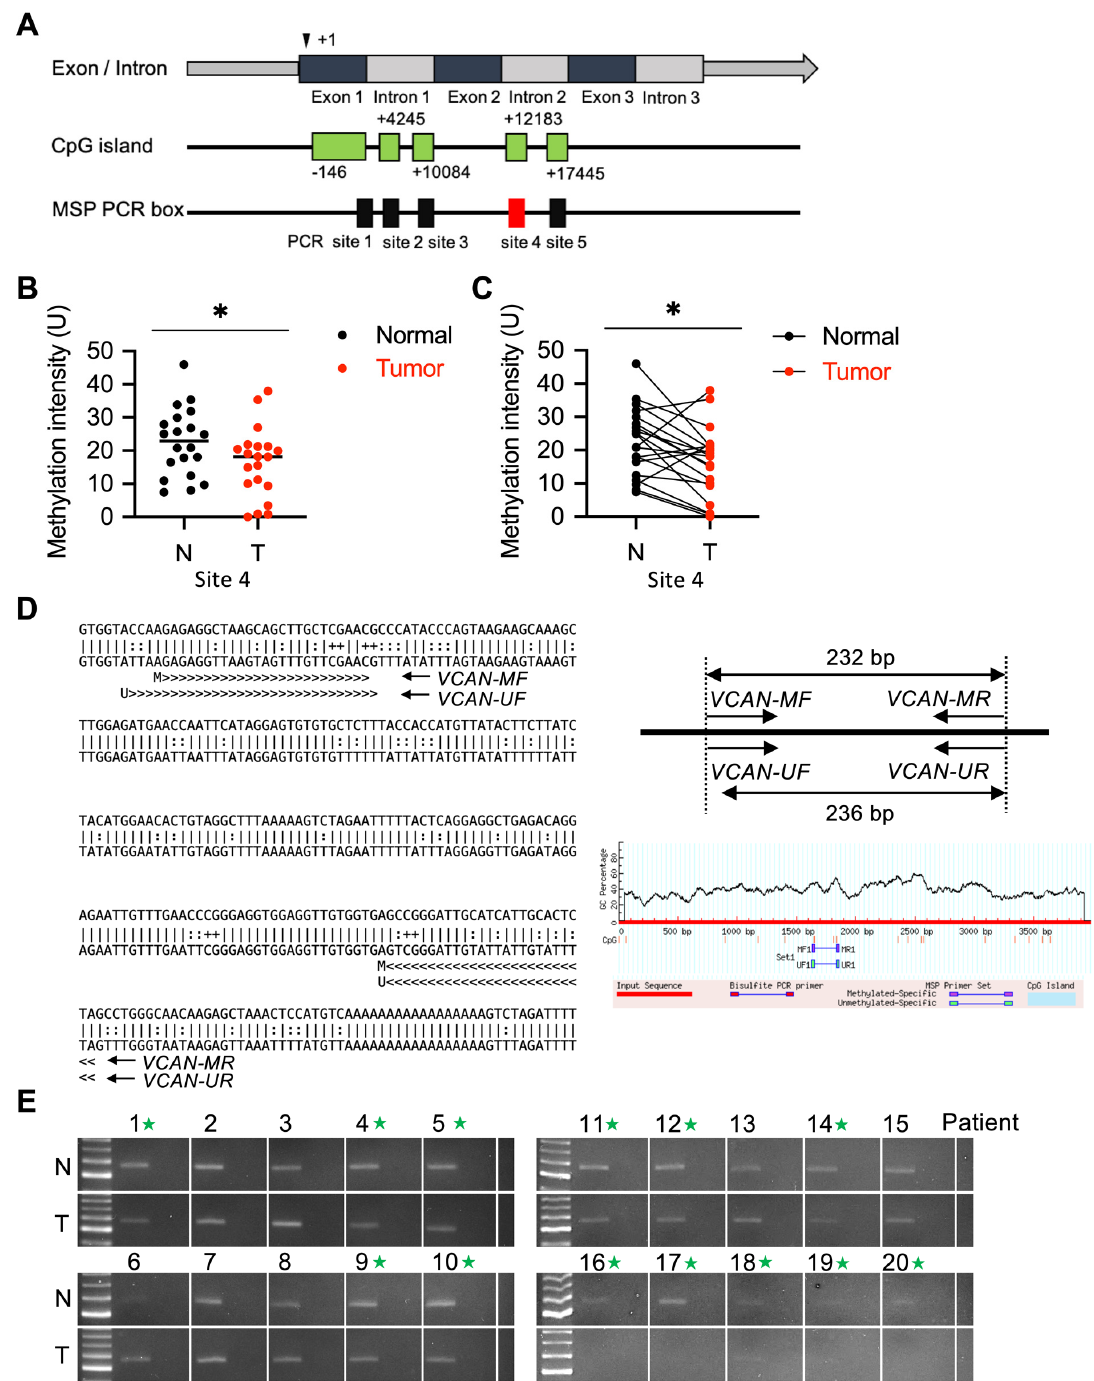
Figure 3. Low methylation of the VCAN in UTUC tumors. The VCAN gene is located on chromosome 5, and CpG islands were identified using the DBCAT and MethPrimer software. Five CpG islands were analyzed using methylation-specific PCR (MS-PCR) to quantify the level of methylation ( A ). The methylation of VCAN in site four was significantly lower in UTUC tumors compared to normal samples ( p = 0.0145) ( B ). The methylation intensity of N/T pairs in site four also revealed a significant reduction in VCAN ( C ). Schematic of the predicted sequence and primer sets for site four ( D ). DNA agarose gel analysis was performed to quantify the methylation in site four from N/T pairs of UTUC ( E ). Statistical analysis was performed by a paired t-test; green asterisk, higher methylation level in the tumor tissues. * p < 0.05.